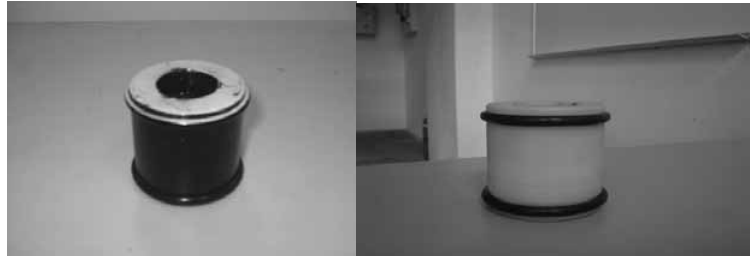
Fig. 4. Sample of the fabricated steel and Teflon dampers.